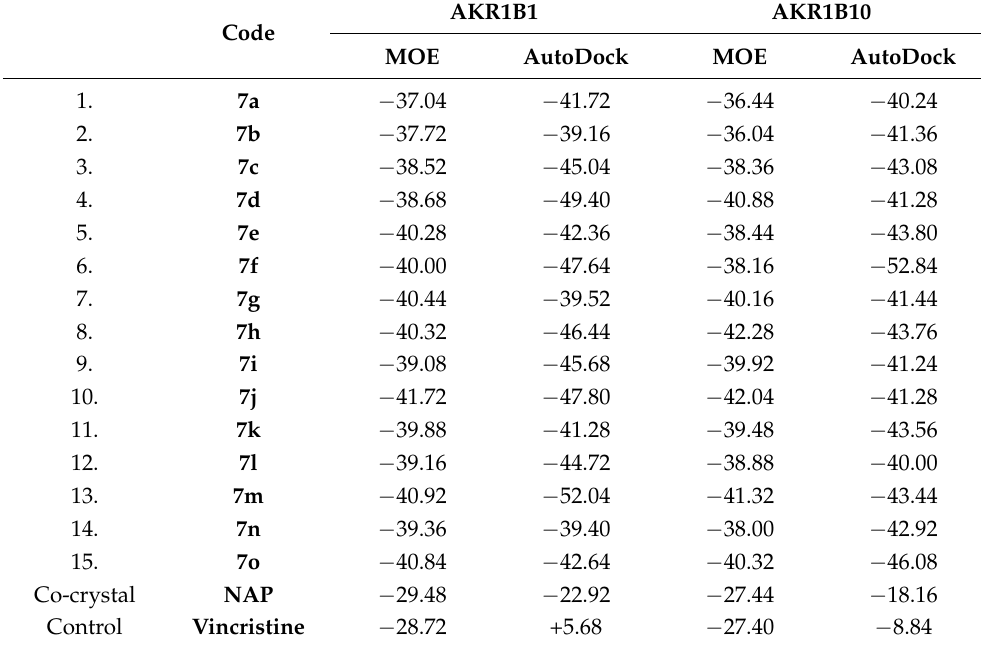
Table 2. Binding energies with target AKR1B1 and AKR1B10 (kJ/mol). Code